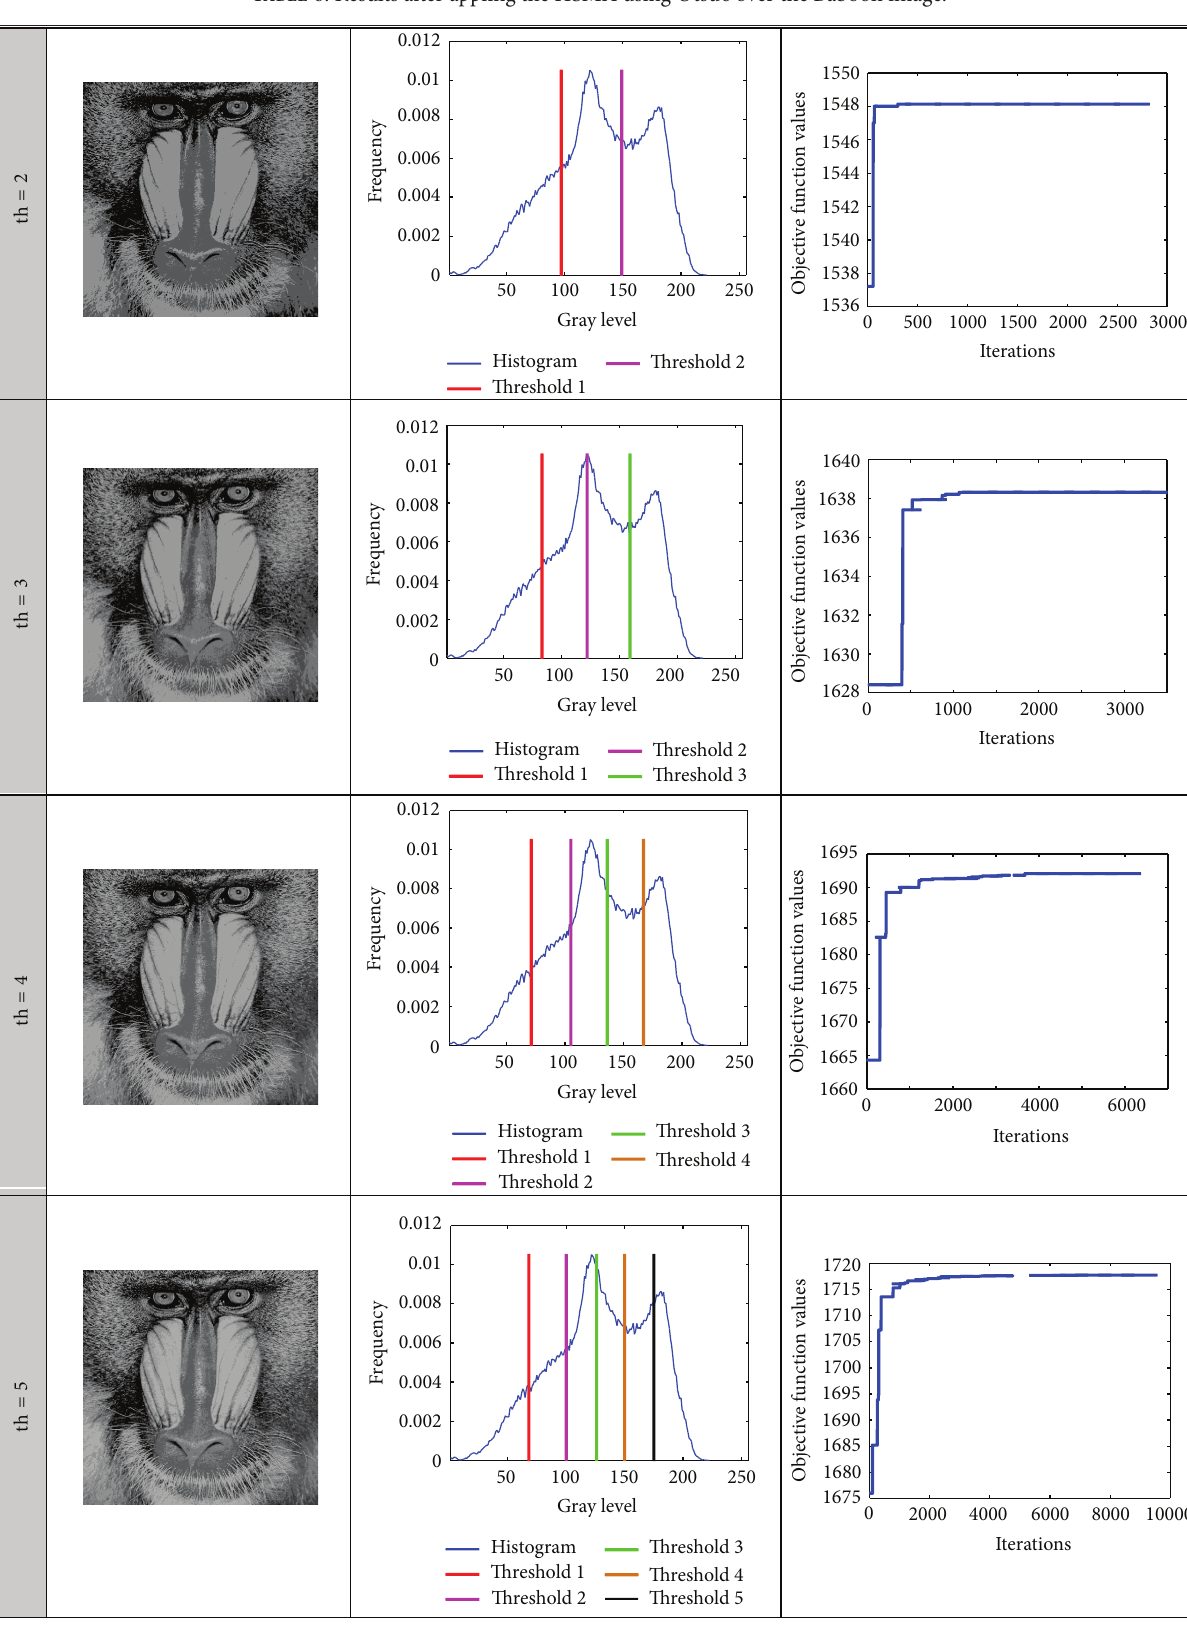
Table 6: Results after appling the HSMA using Otsu’s over the Baboon